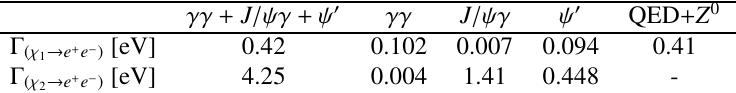
Table 2. Electronic widths for χ 1 and χ 2 . See text for